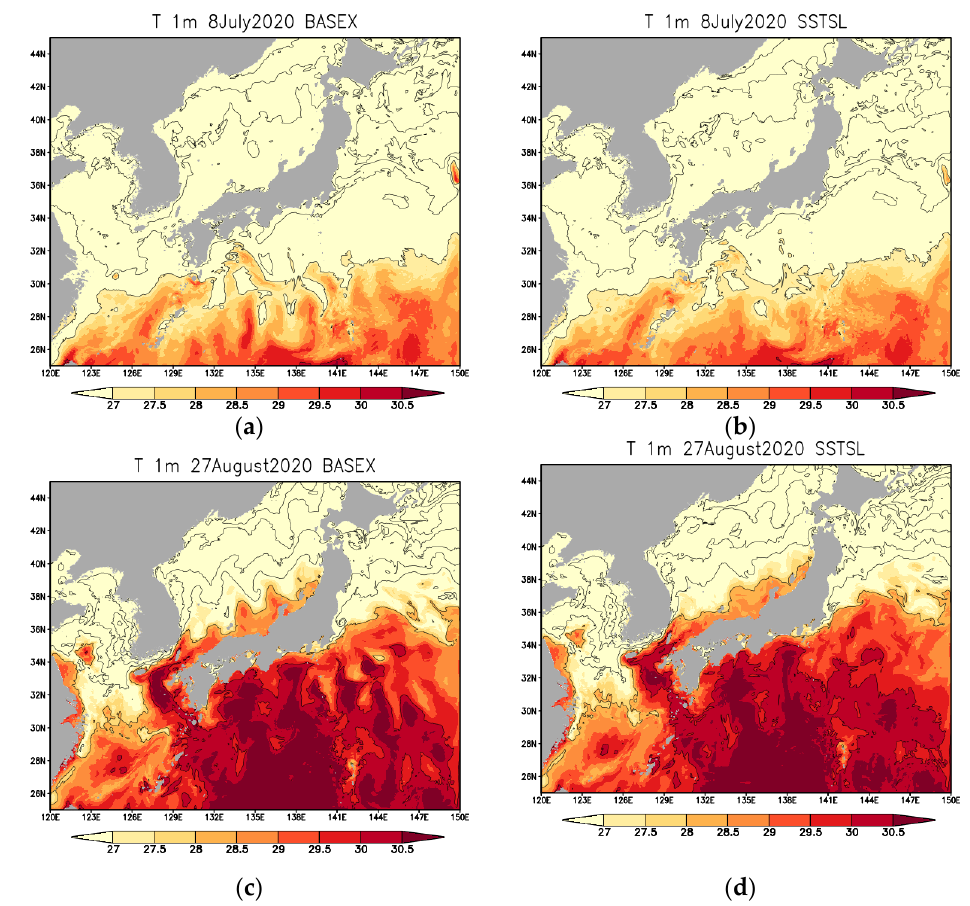
Figure 10. Modeled daily mean SST (in ◦ C). ( a , b ): 8 July 2020. ( c , d ): 27 August 2020. ( a , c ): the BASEX case, ( b , d ): the SSTSL case. Contours denote isotherms with 1 ◦ C interval. The color bar range is determined for visualizing the streaks shown in the BASEX